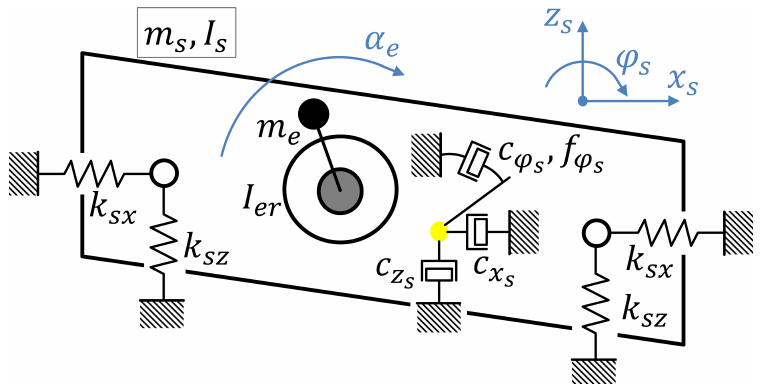
Figure 2. Mechanical representation of the dynamic model of vibrating screen with a single mechanical